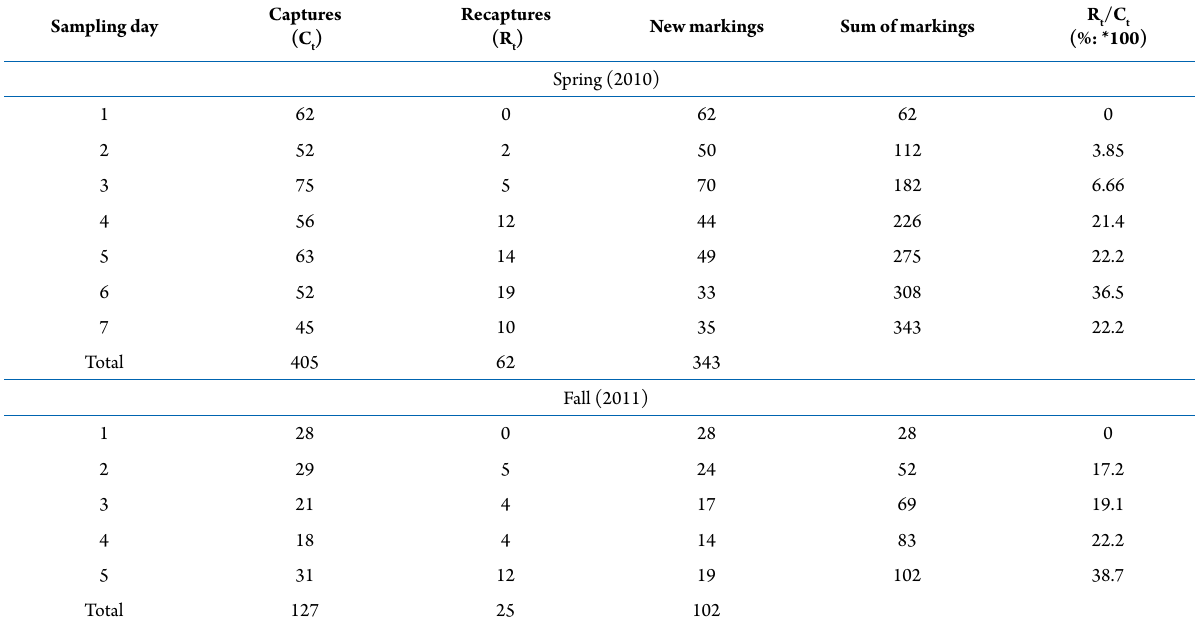
Table 2. Number of adult aeglids captured, marked and recaptured in each sampling day, in spring 2010 and in fall